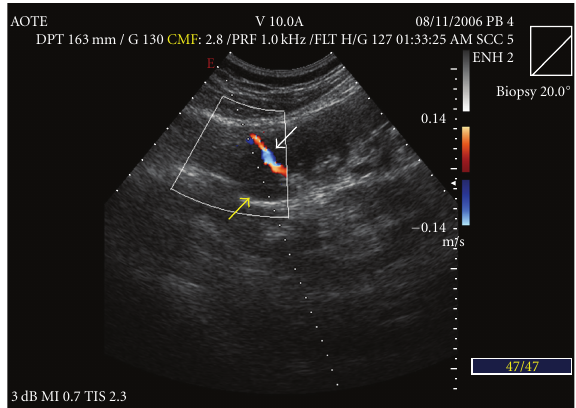
Figure 1: Colour Doppler US examination discloses perforant artery (white arrow) at the inferior pole of left kidney (yellow